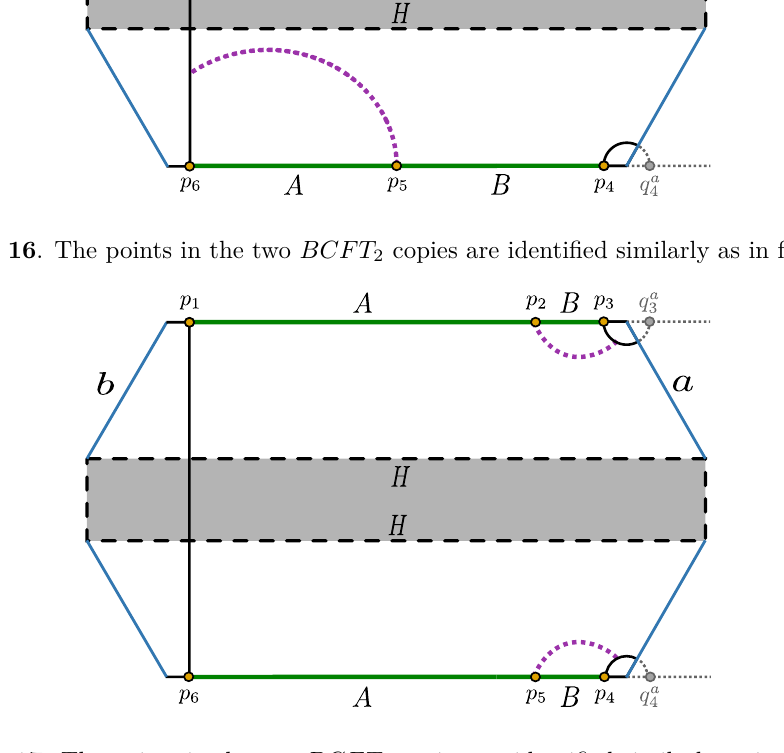
Figure 17 . The points in the two BCFT 2 copies are identified similarly as in figure